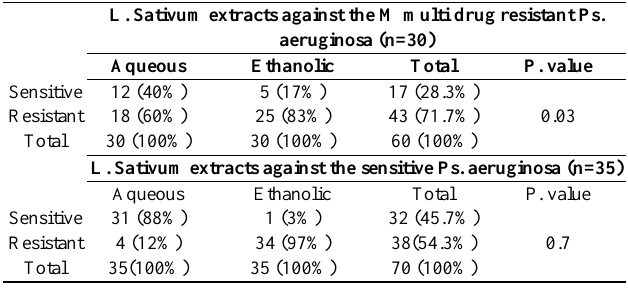
Table 4: Frequency of Aantimicrobial effect of L. Sativum extracts against the Mmulti drug resistant and sensitive Ps.